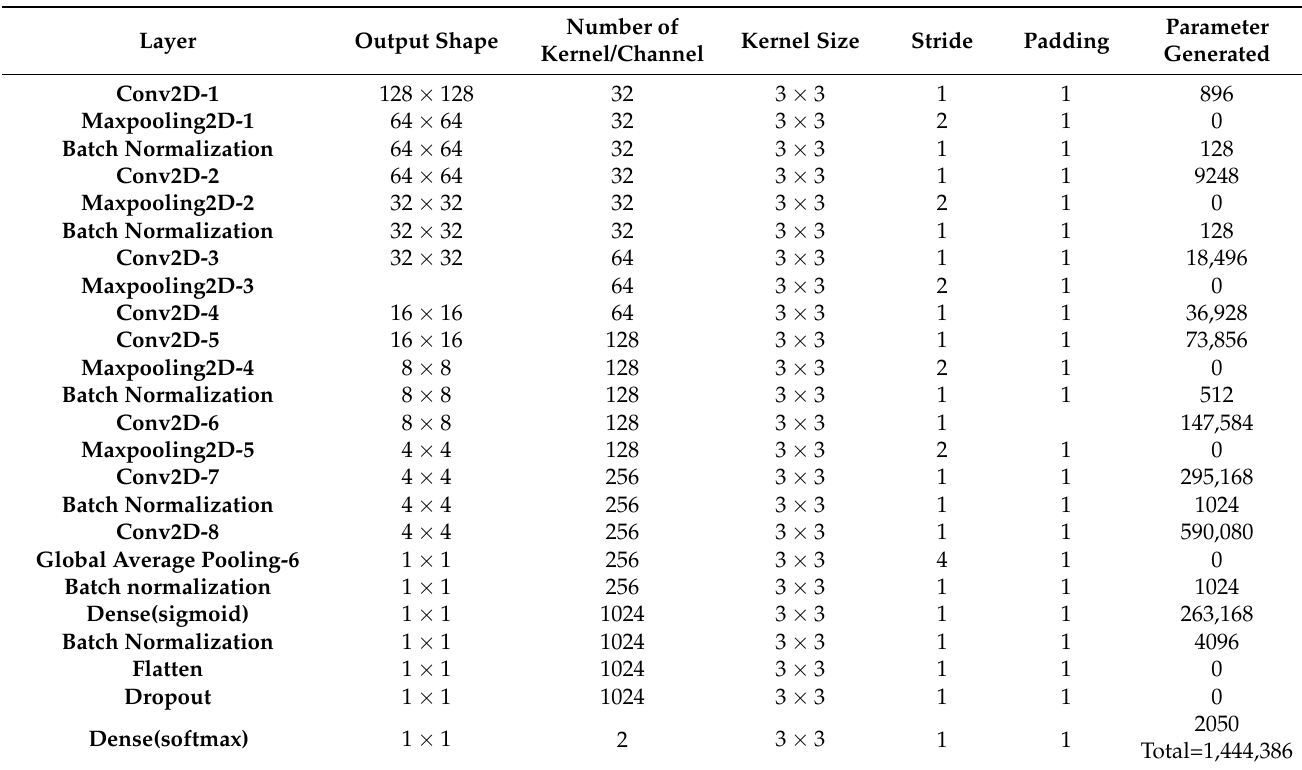
Table 3. Summary of parameter used in the proposed